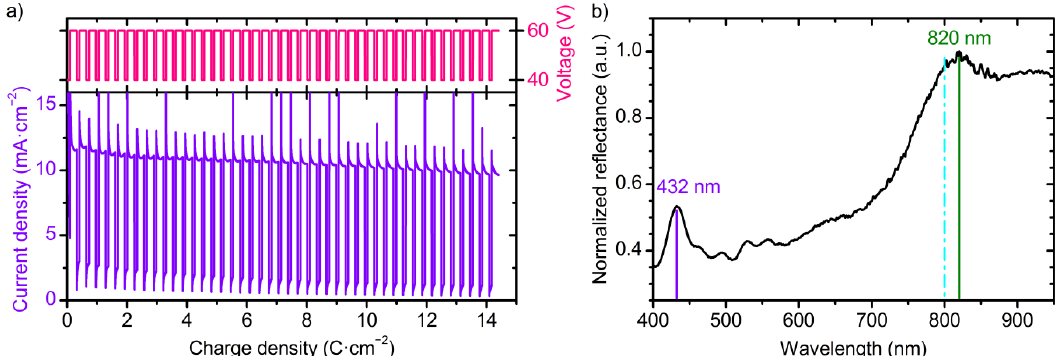
Figure 5. Data for PC_4 with OPL of the layers obtained at 40 and 60 V equal to 0.25 L 0 and 0.75 L 0 , respectively. PC_4 was prepared using Equations (5) and (6) for the OPL calculation. Parameters of the synthesis: t 0 = 70 min; L total = 18000 nm; L 0 = 400 nm. ( a ) Dependences of anodizing voltage and current density on charge density. ( b ) Reflectance spectrum at normal incidence of light. Violet and green lines show positions of the first (820 nm) and the second (432 nm) photonic band gaps. Cyan line shows the expected position of the first photonic band gap.